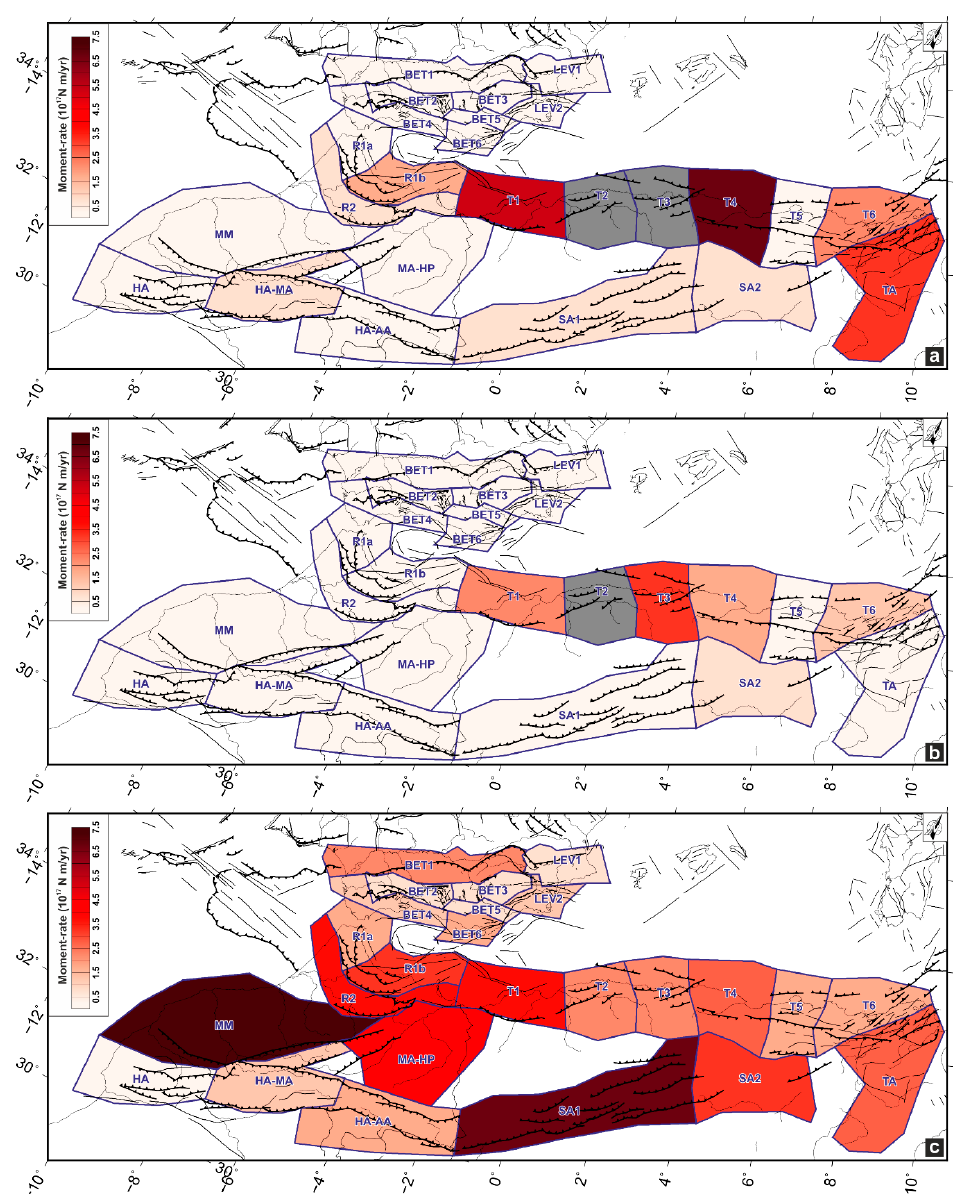
Figure 4. Estimated moment-rates from seismicity, by considering the truncated Gutenberg–Richter distribution ( a ) and by considering the cumulative Kostrov summation method ( b ) and from ( c ) geodetic data (see Table 1 and Table 2 for details). SSZ characterized by moment-rates larger than 7.5 × 1017 Nm/yr are reported in grey. The maps are plotted in an oblique Mercator projection. Computed values range in the interval 4.85 × 10 15 − 3.0 × 10 18 Nm/yr. The higher values ( ≥ 1.0 × 10 17 Nm/yr) are observed along the eastern sector of the Rif (R1b) and along the Tell Atlas region (e.g., T1, T2, T3, T4, T6, and TA), clearly highlighting the high seismic release of this belt. Although T5 belongs to the Tell Atlas region, it shows an estimated moment-rate of ~3.2 × 10 16 Nm/yr, a very low